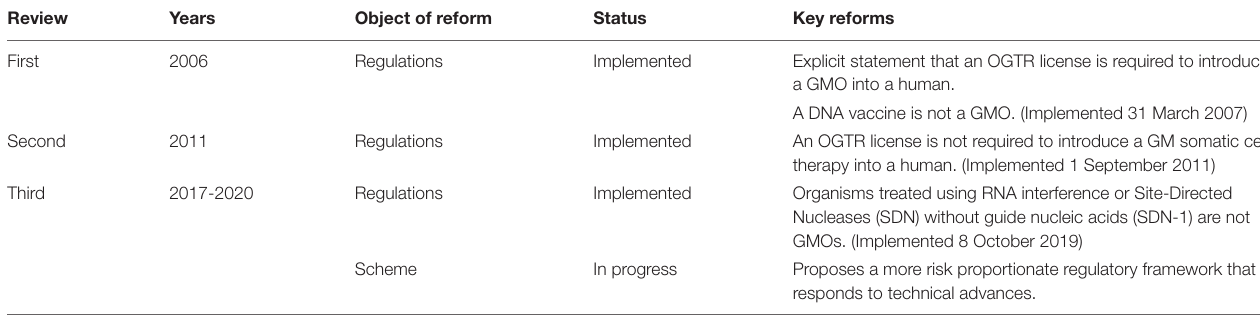
TABLE 1 | Australian regulatory reforms relevant to human gene-based